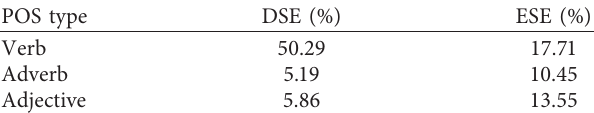
Table 1: Part-of-speech ratio of subjective expressive